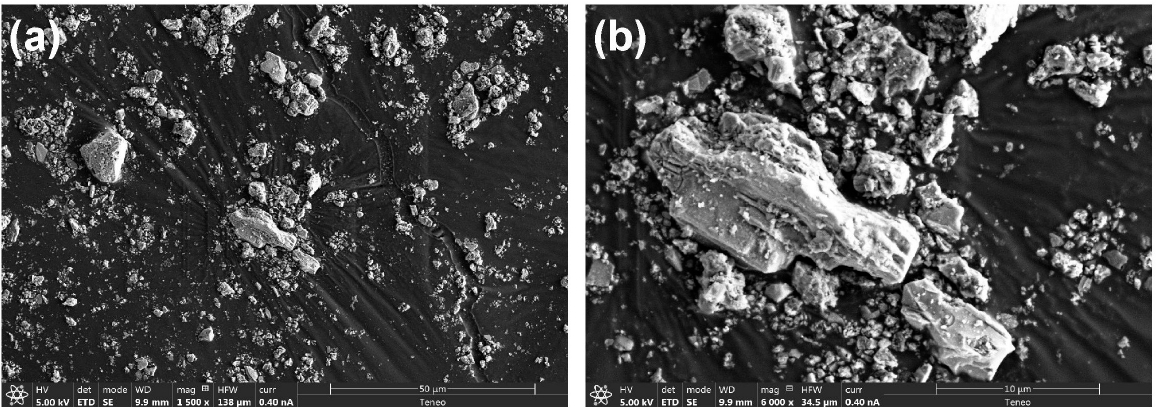
Figure 3. Scanning electron microscope image of ladle furnace slag with the secondary option: ( a ) 1500×; ( b ) 6000×.